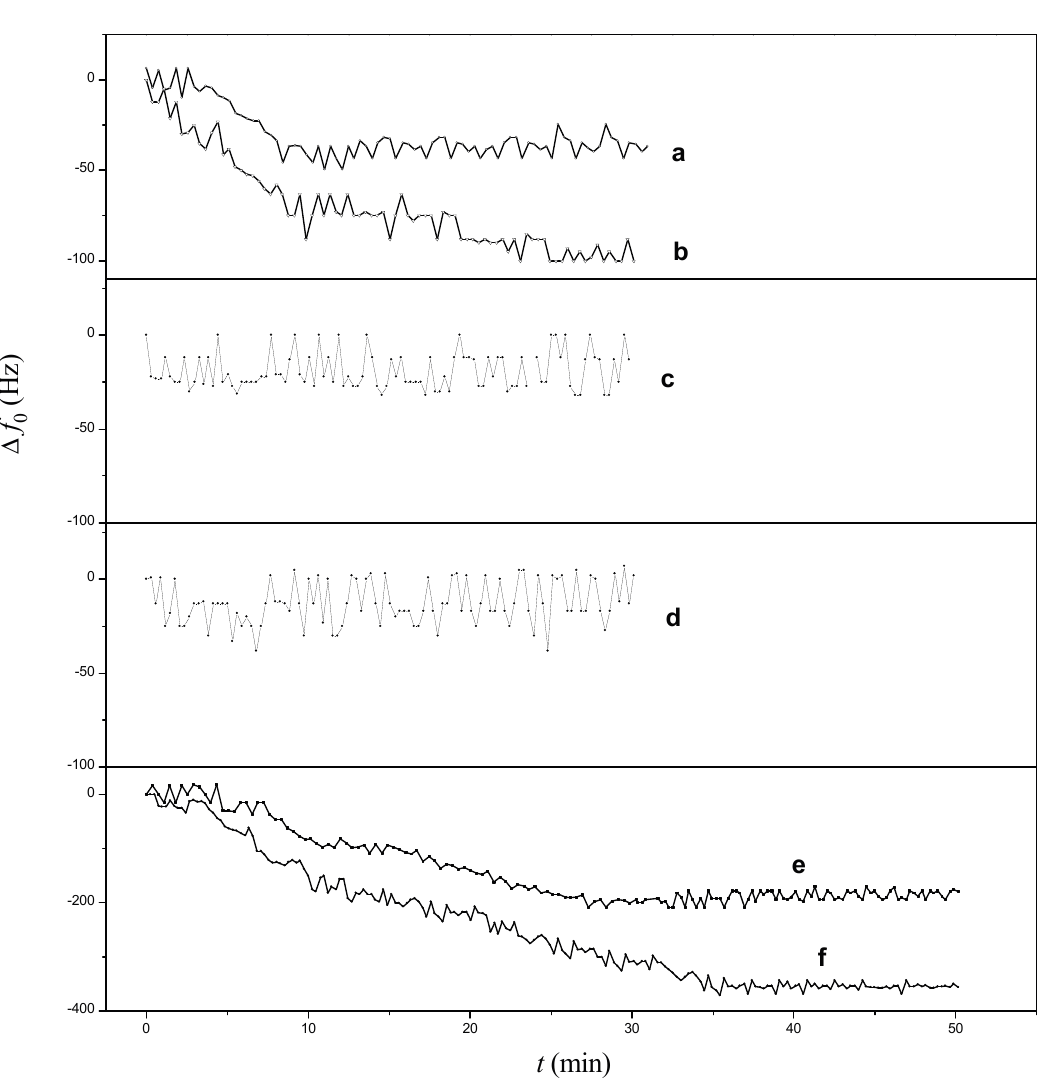
Figure 6. Continuous monitoring frequency response for different devices in different samples: ( a ) PDMS-mQCM in 25% serum; ( b ) PDMS-mQCM in 75% serum; ( c ) A β